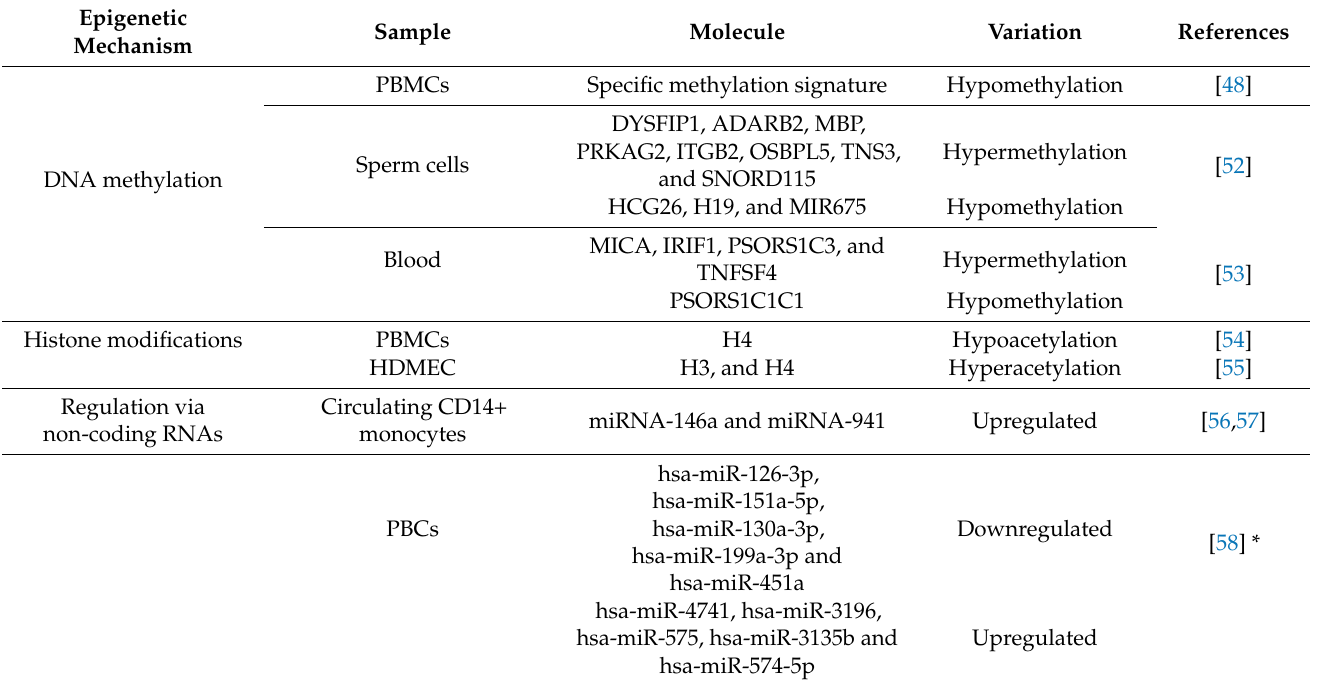
Table 2. Epigenomic studies in psoriatic